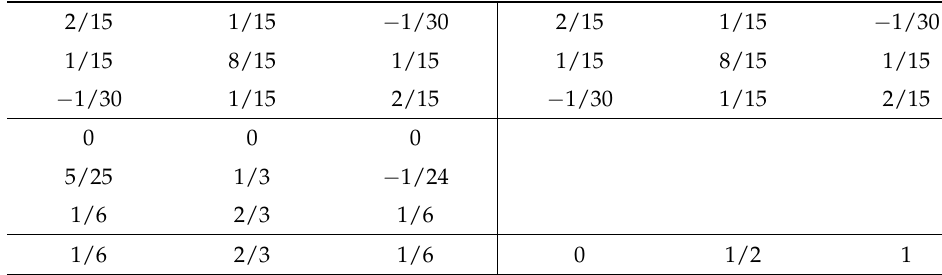
Table A5. L3|L3 method.